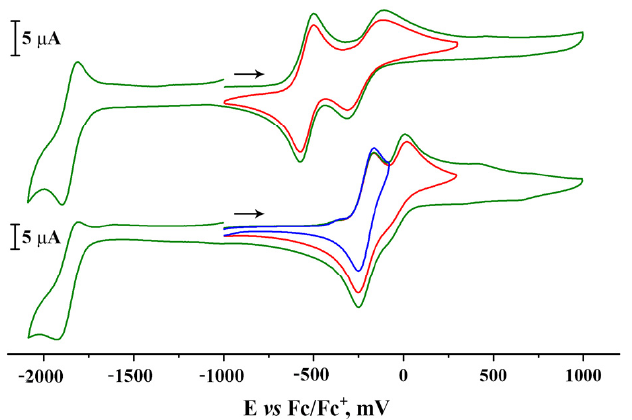
Figure 5. The CV data for 2 (top view) and 1 (bottom view) (GC electrode, Ag/AgCl/KCl, 0.2 M Bu 4 NClO 4 , CH 2 Cl 2 , C = 2 × 10 −3 mol/dm 3 , V = 0.2 V·s −1 , Ar). Corrections to Fc/Fc + couple as a standard were made.